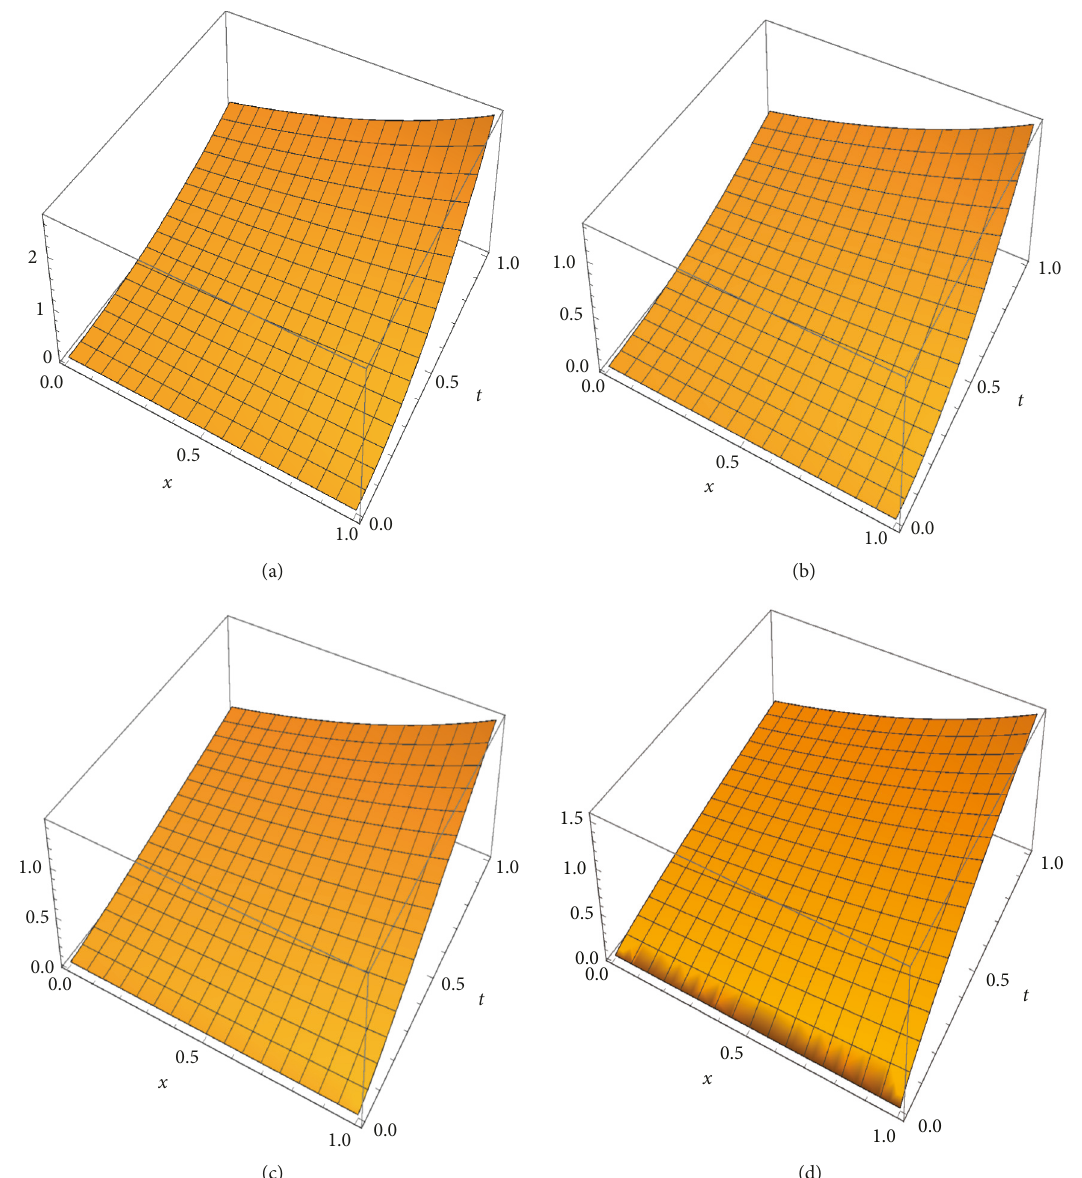
Figure 1: (a) 𝛼 = 1 (exact), (b) 𝛼 = 0.8 (3-term FRDTM), (c) 𝛼 = 0.6 , and (d) 𝛼 = 0.4